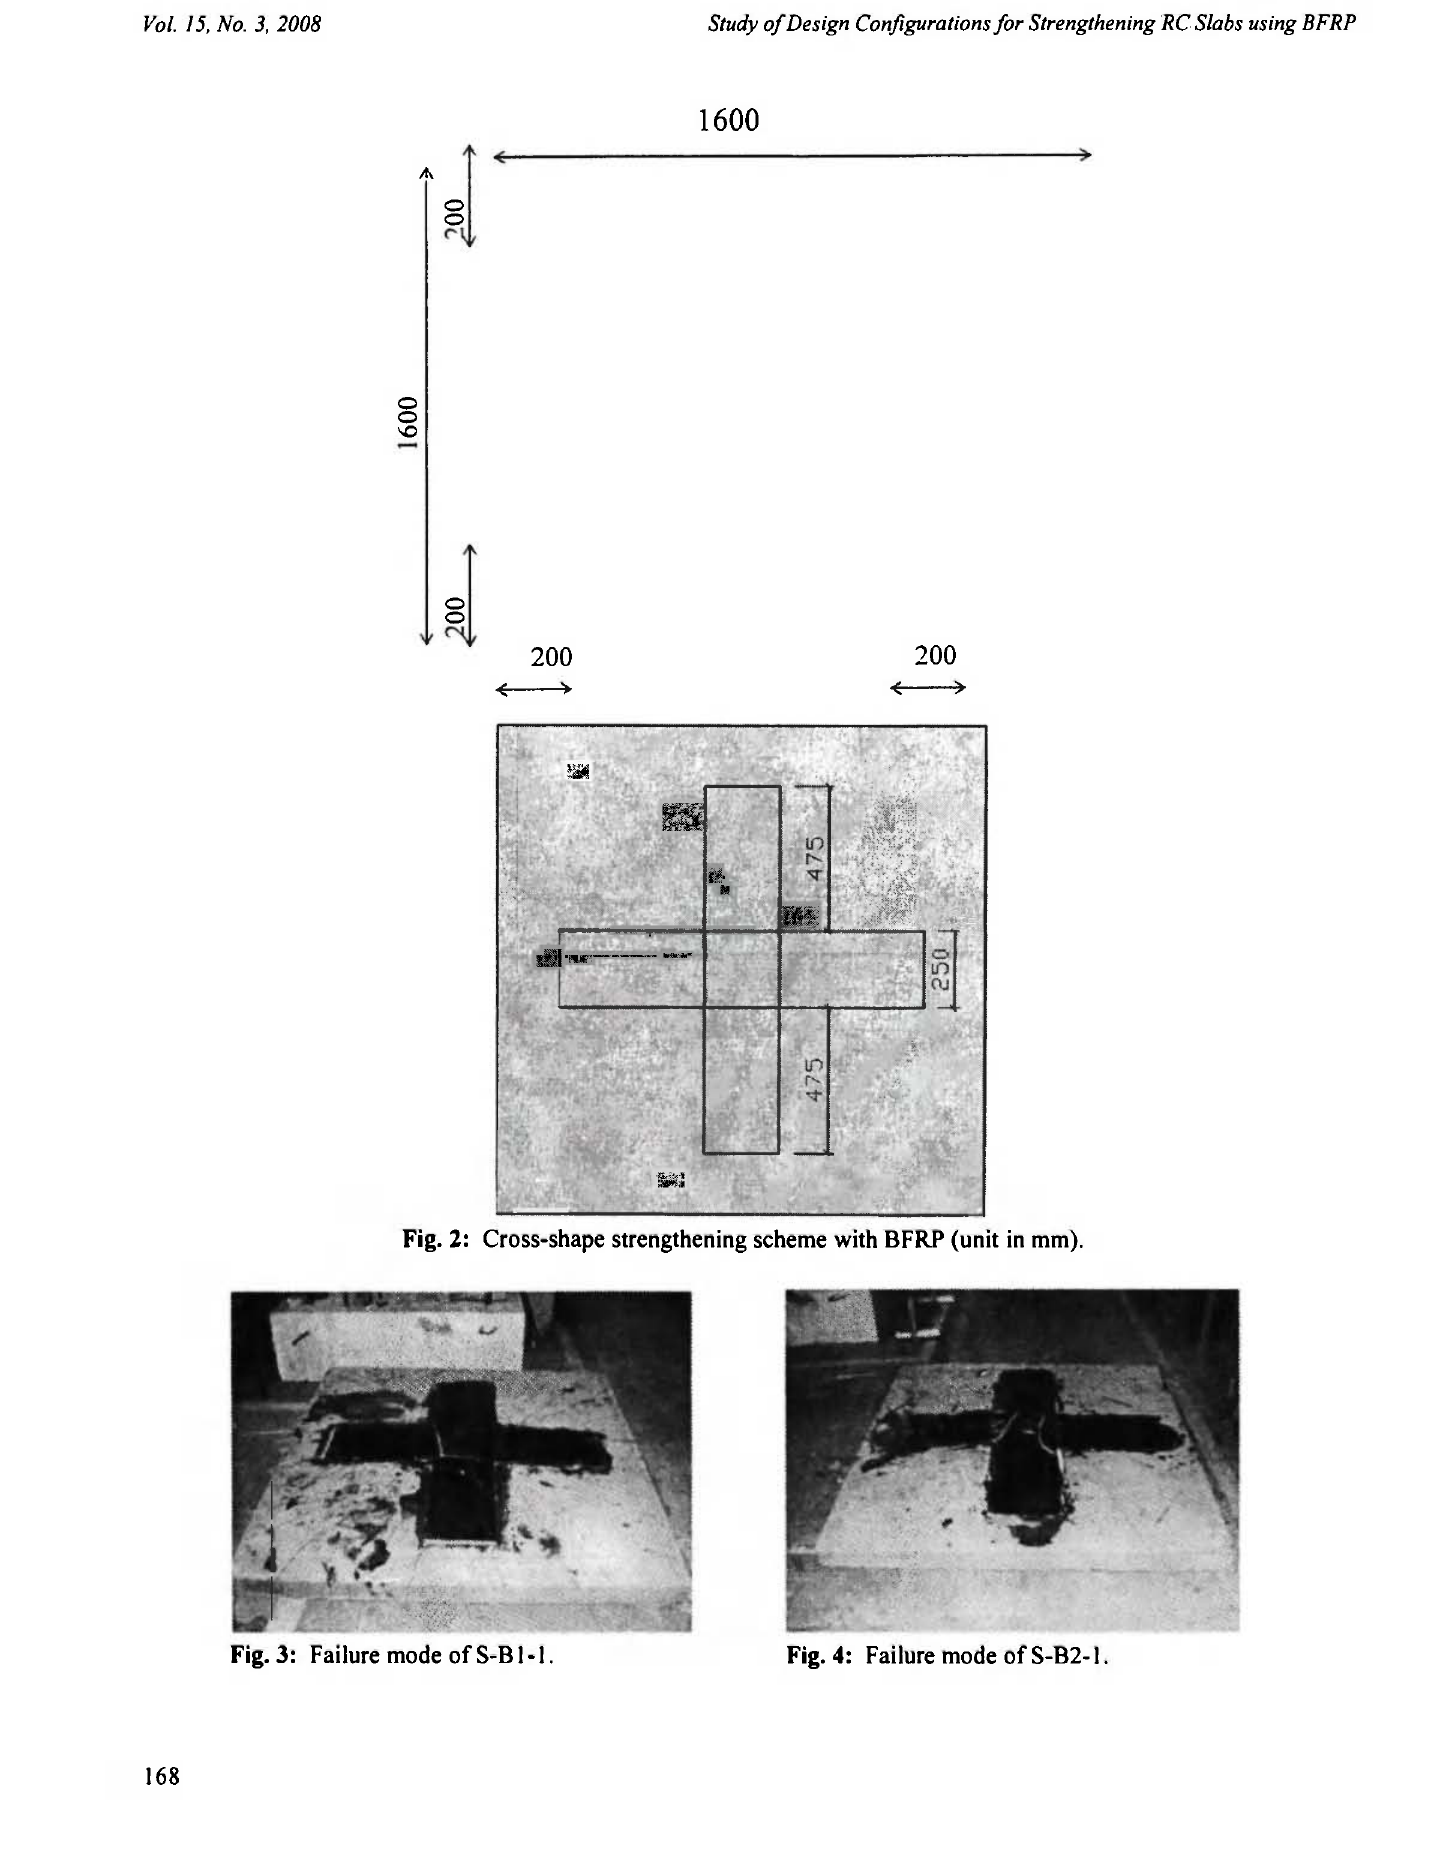
Fig. 3: Failure mode of S-B1-1. Fig. 4: Failure mode of S-B2- 1